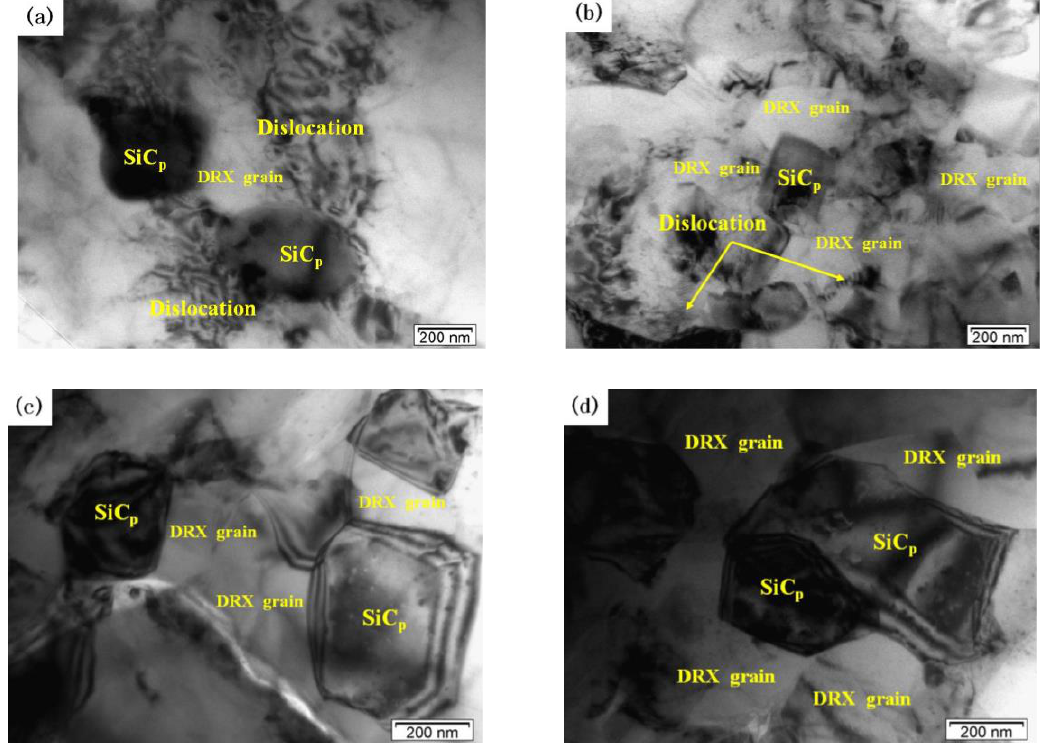
Figure 9. TEM images of the dual-scale SiCp/A356 composites deformed at 500 °C and different strain rates: ( a ) 5 s −1 ; ( b ) 1 s −1 ; ( c ) 0.1 s −1 ; ( d ) 0.01 s −1.